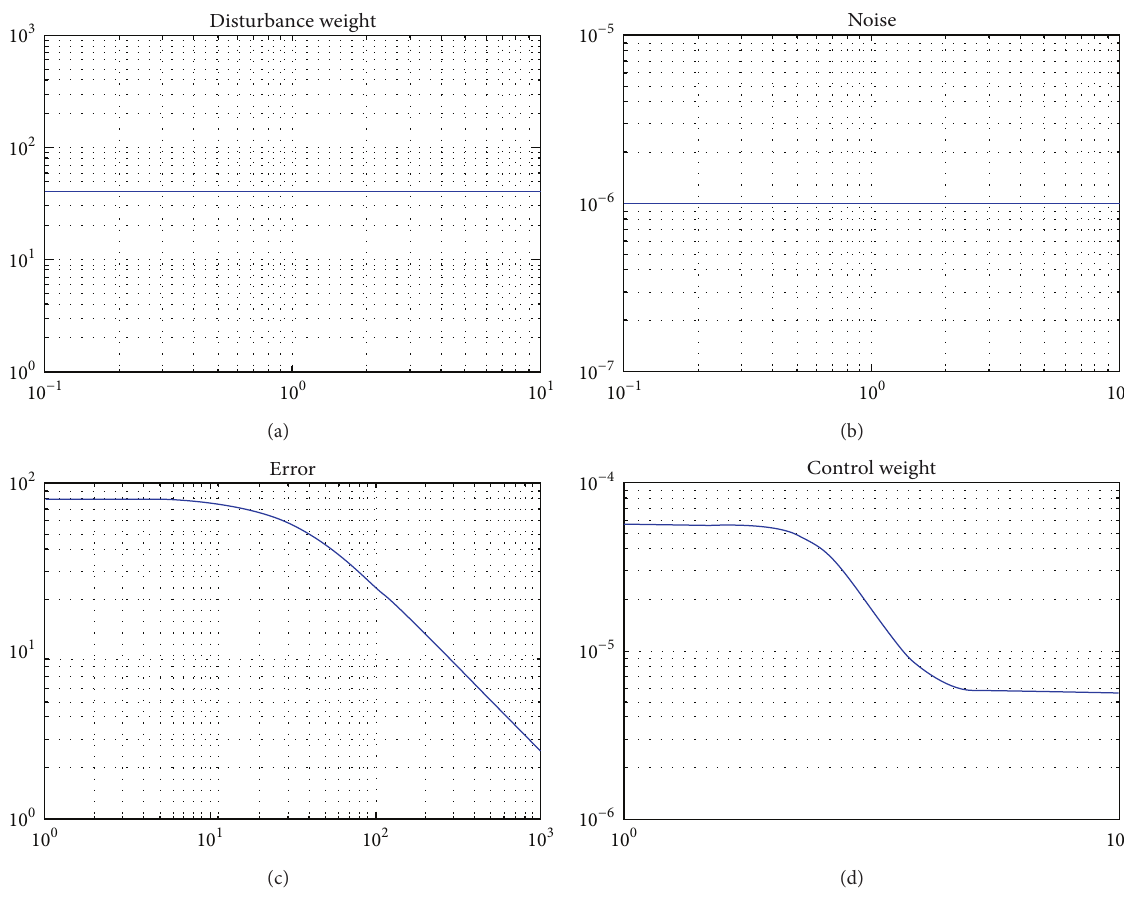
Figure 10: Bode diagrams of diagonal elements of weight